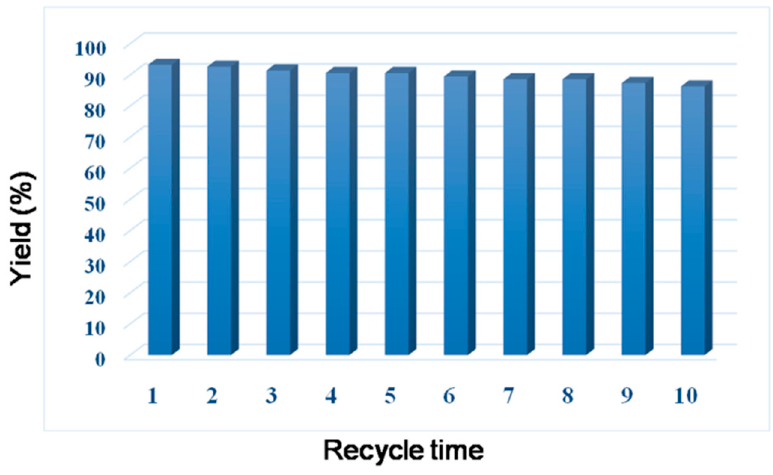
magnetic field. ( a ) the reaction products and Fe 3 O 4 nanoparticles before the external magnetic field; ( b ) the reaction products and Fe 3 O 4 nanoparticles after the external magnetic field.